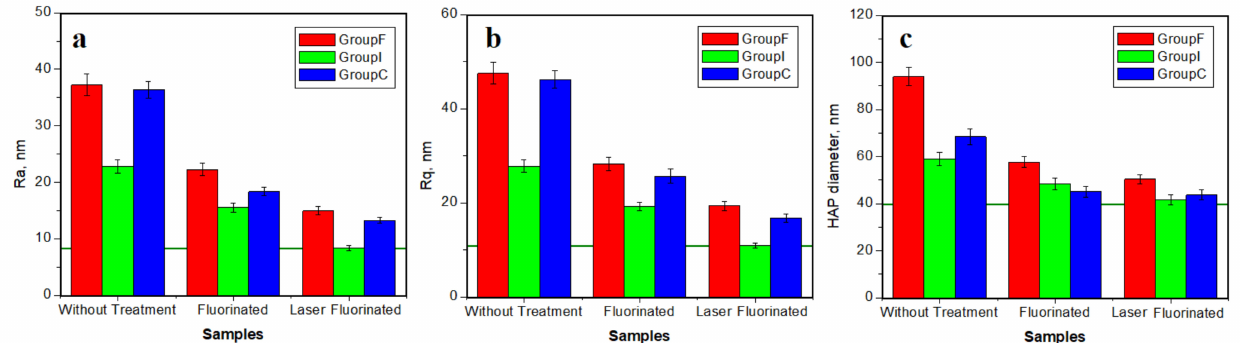
Figure 5. Average roughness variation with the applied treatment at the nanostructure level: ( a ) Ra , ( b ) Rq , and ( c ) nanostructural unit diameter. The horizontal green line on the histograms represents the typical value for healthy